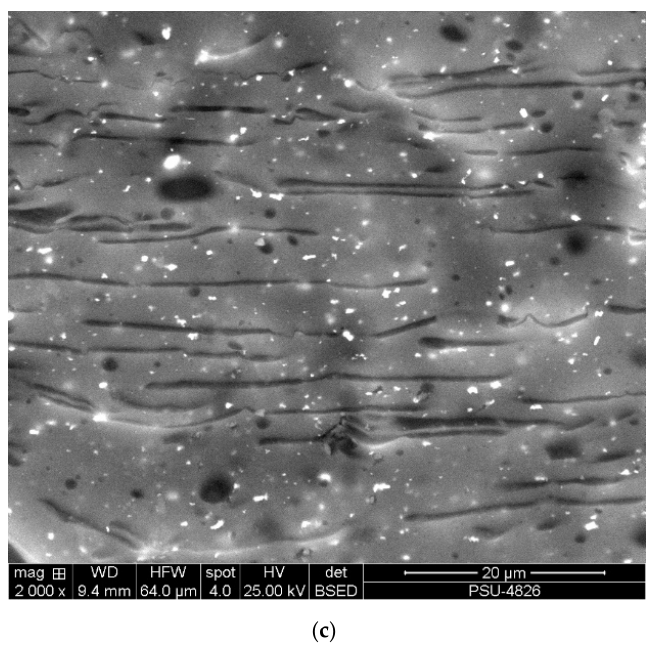
Figure 1. Fractured surface micrographs of Standard Thai Rubber 5L (STR5L)/polycaprolactone (PCL) blends: ( a ) STR5L/PCL 25/75, ( b ) STR5L/PCL 50/50, and ( c ) STR5L/PCL 75/25.